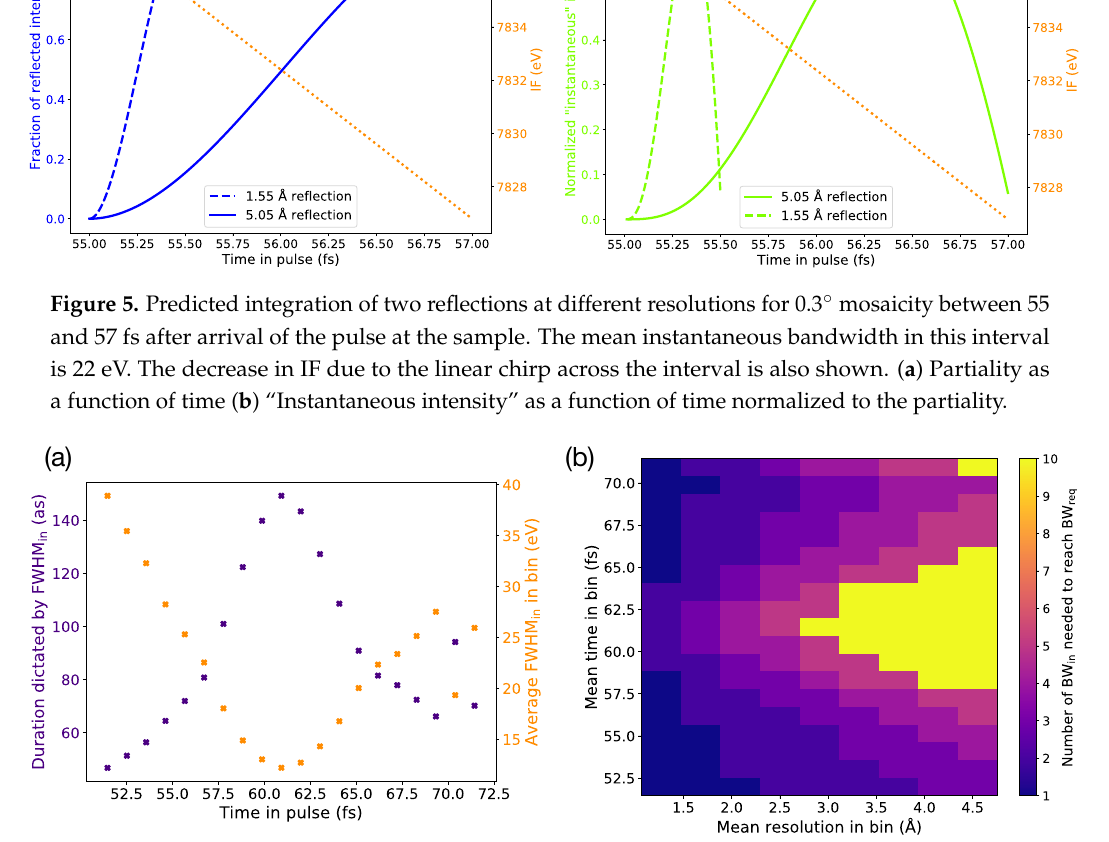
Figure 6. Properties set by BW in . ( a ) Instantaneous duration set by the mean FWHM in for each time bin. These intervals are all smaller than the 200-as set by the single SASE spike width. ( b ) Energy/time points expected per reflection at different times in the pulse and different resolutions (up to 5 Å). All bins at resolutions lower than 5 Å were assigned a value of 10 and are not shown in the